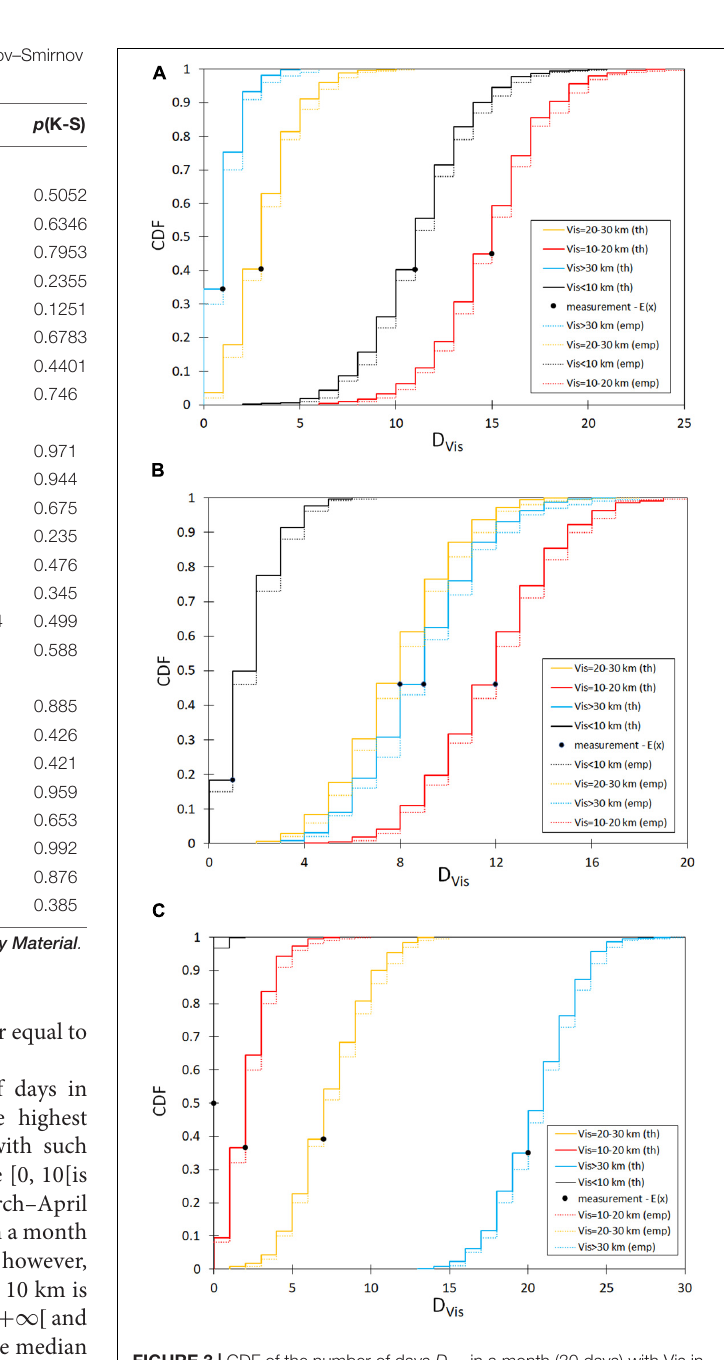
FIGURE 3 | CDF of the number of days D Vis in a month (30 days) with Vis in given range, “th” in the legend stands for theoretical CDF (calculated from the described model), “emp” denotes CDF from measurements, and E ( x ) is the expected value of D Vis for the (A) winter period, (B) mid-period, and ( C ) summer